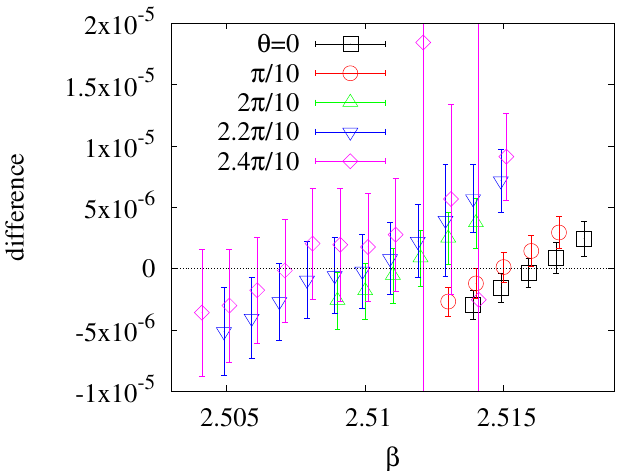
Figure 10 . The difference of the energies between the two minima is shown as a function of β .